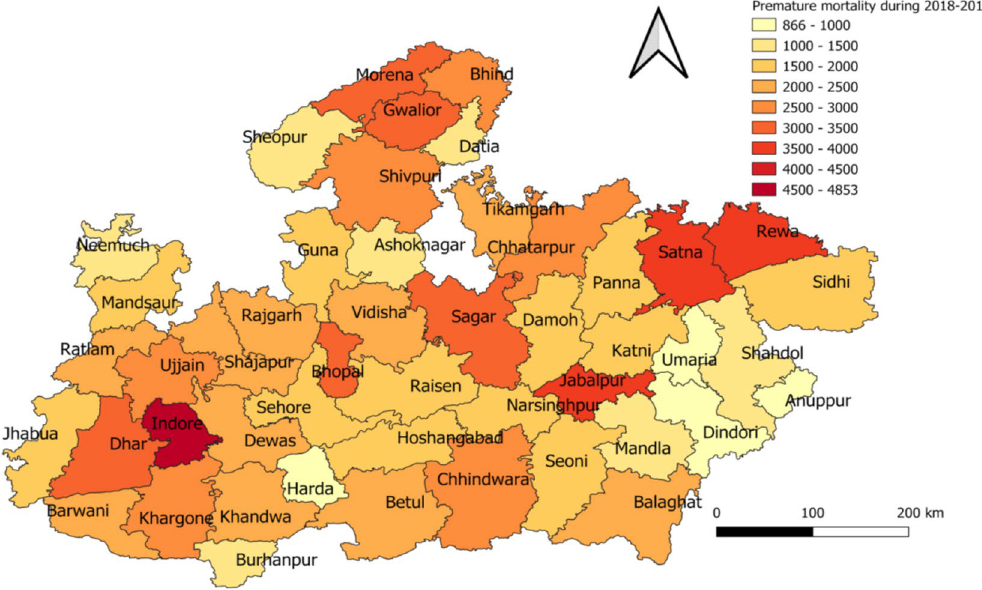
Figure 6. Total premature deaths in MP due to exposure to ambient PM 2.5 concentration during 2018–2019. This map is generated using QGIS 2.18.1